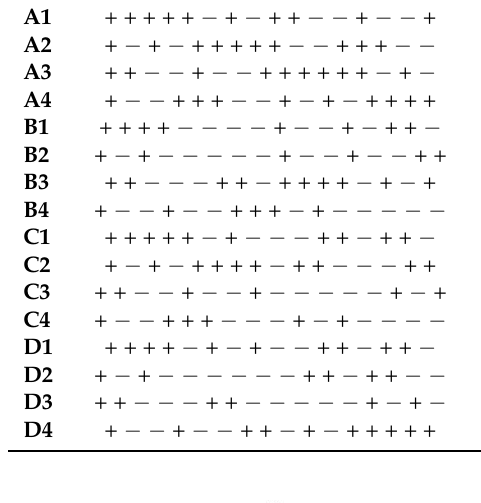
Table 1. Complete Complementary Code scheme.